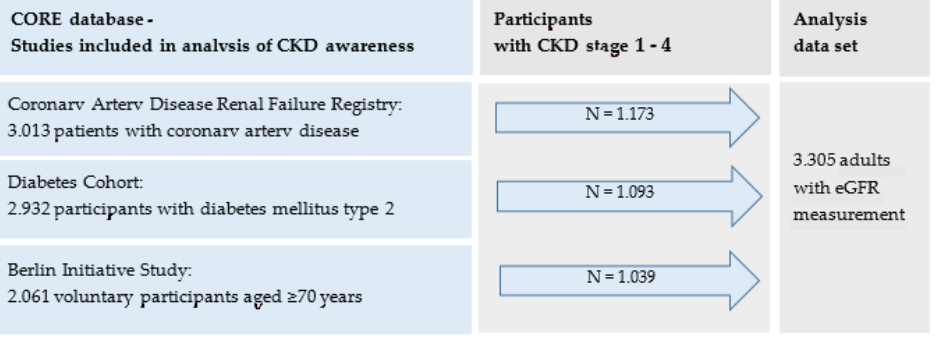
Figure 2. Flowchart: contributing cohorts and number of participants with CKD.